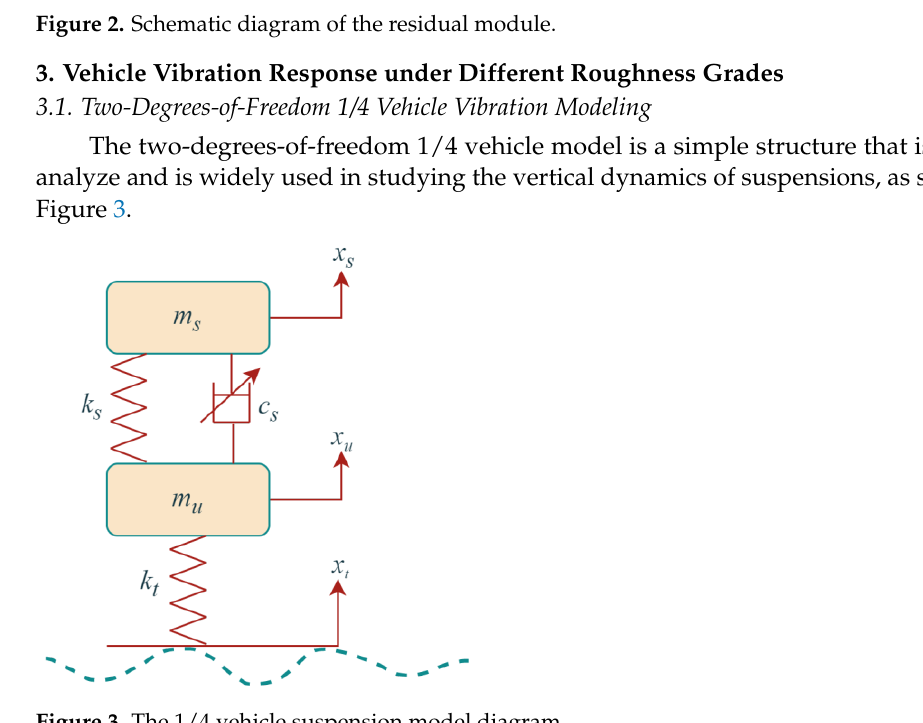
relative height of the pavement, the reference surface, and the road direction. The pavement roughness function is random, often considered to have a mean value of zero, and obeys a normal distribution, and the power spectral density can be used to express its